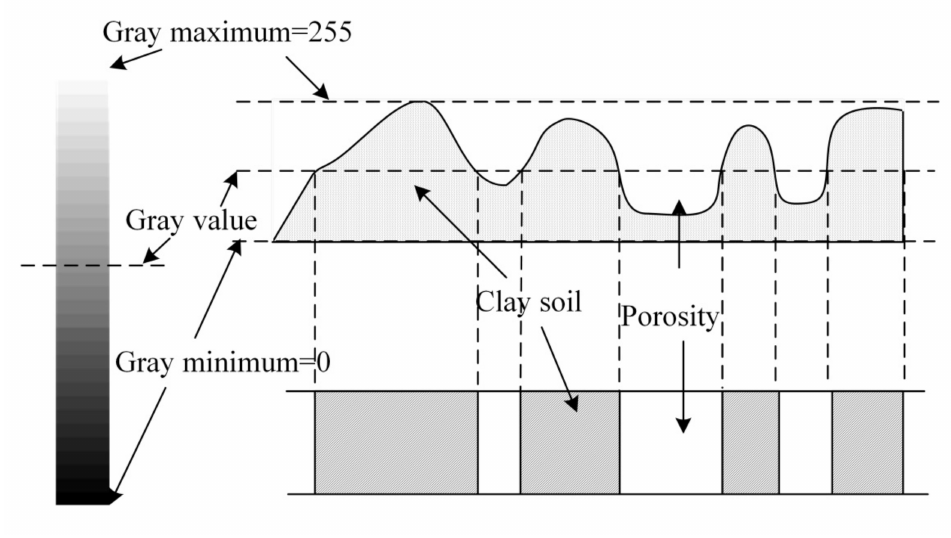
Figure 1. Principle diagram of the binarization